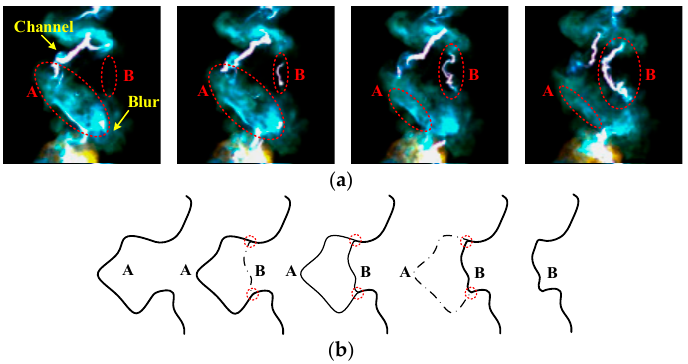
Figure 7. Local short circuit process of arc column: ( a ) high speed images of local short circuit process; ( b ) mechanism diagram of local short circuit process.